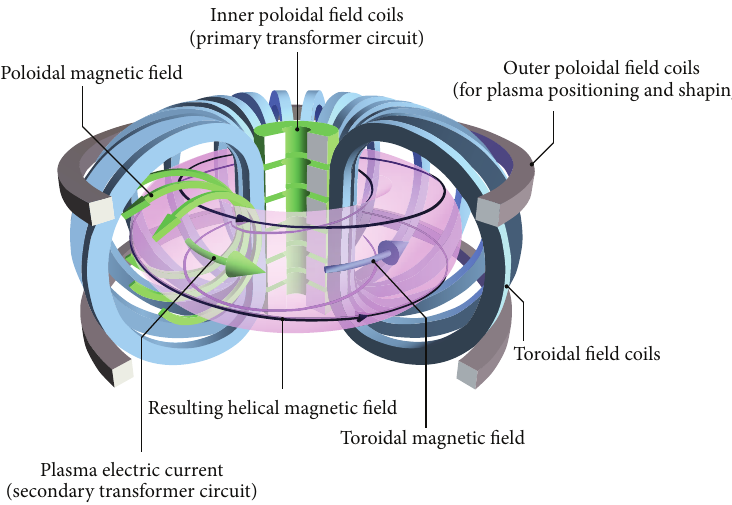
Figure 1: Schematic of a tokamak chamber and magnetic